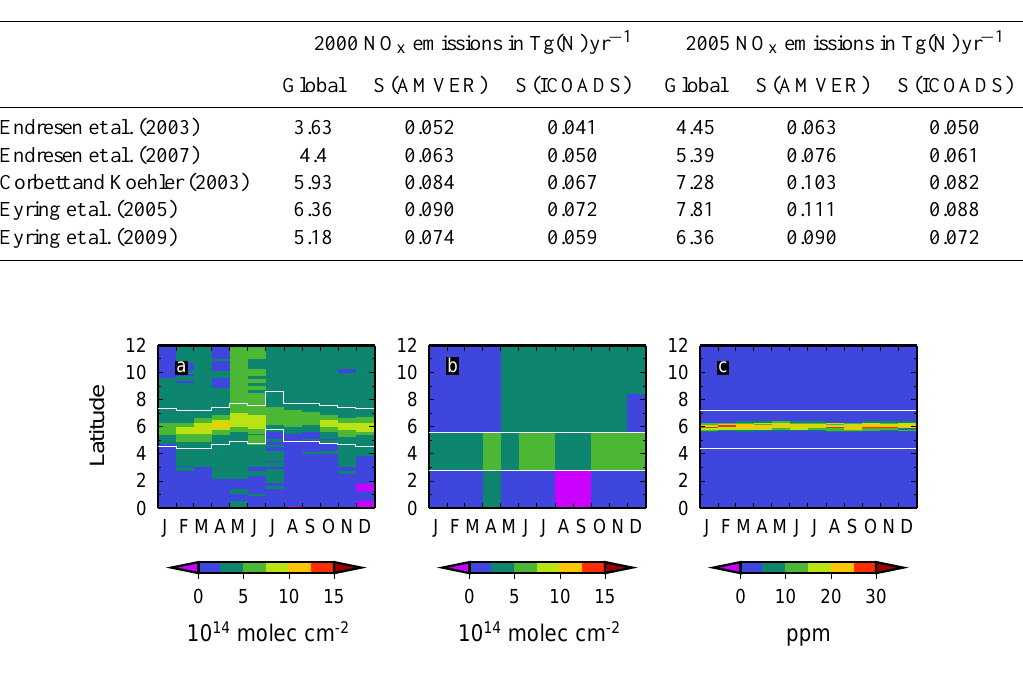
Table 3. NO x ship emissions from previous studies. The table summarizes the global emission total and the emission into region S (83 ◦ E– 94.2 ◦ E/4.4 ◦ N–7.2 ◦ N) for different spatial ship activity patterns (AMVER and ICOADS). Emission rates for 2000 are scaled with the increase of total seaborne trade to the year 2005.